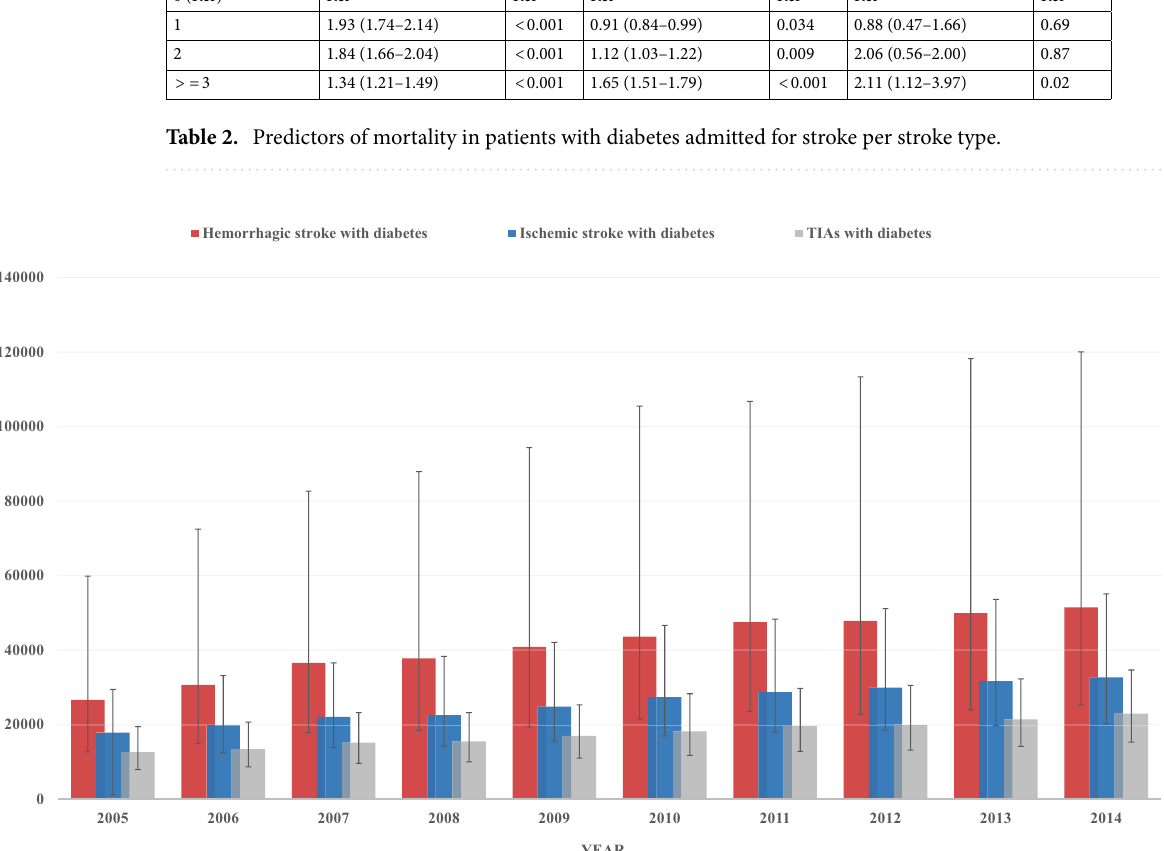
Figure 5. Median (IQR) total hospital charges (USD/stay—adjusted for inflation) of patients with diabetes and hemorrhagic stroke, ischemic stroke, and